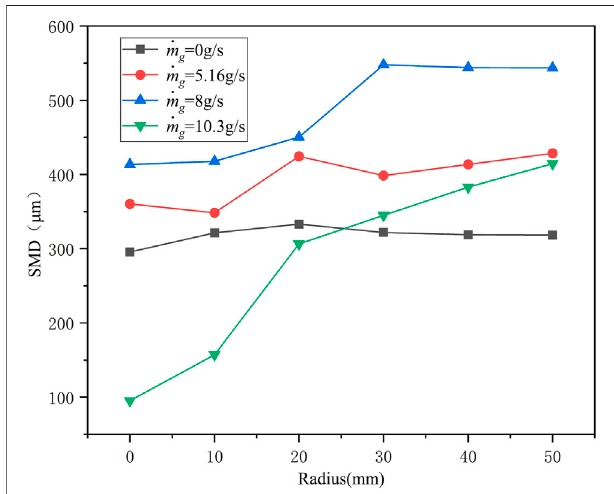
FIGURE 11 | Radial distribution of SMD under conditions with different gas-liquid ratios.